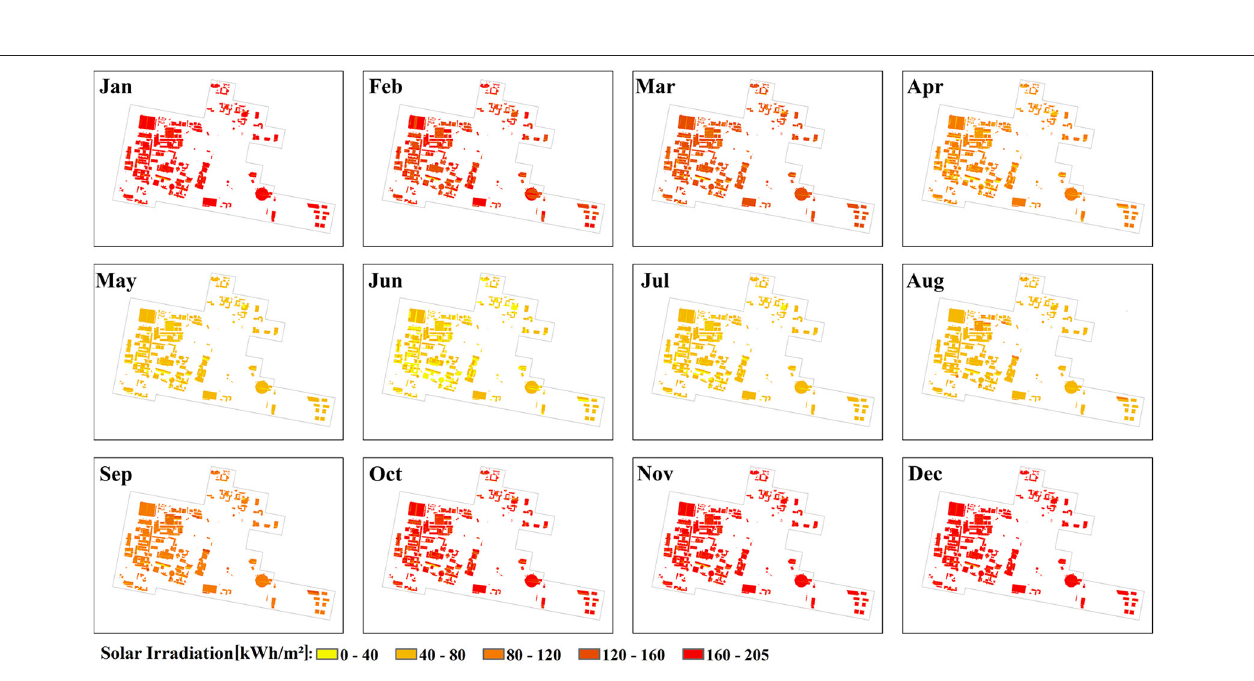
FIGURE 6 | Monthly solar